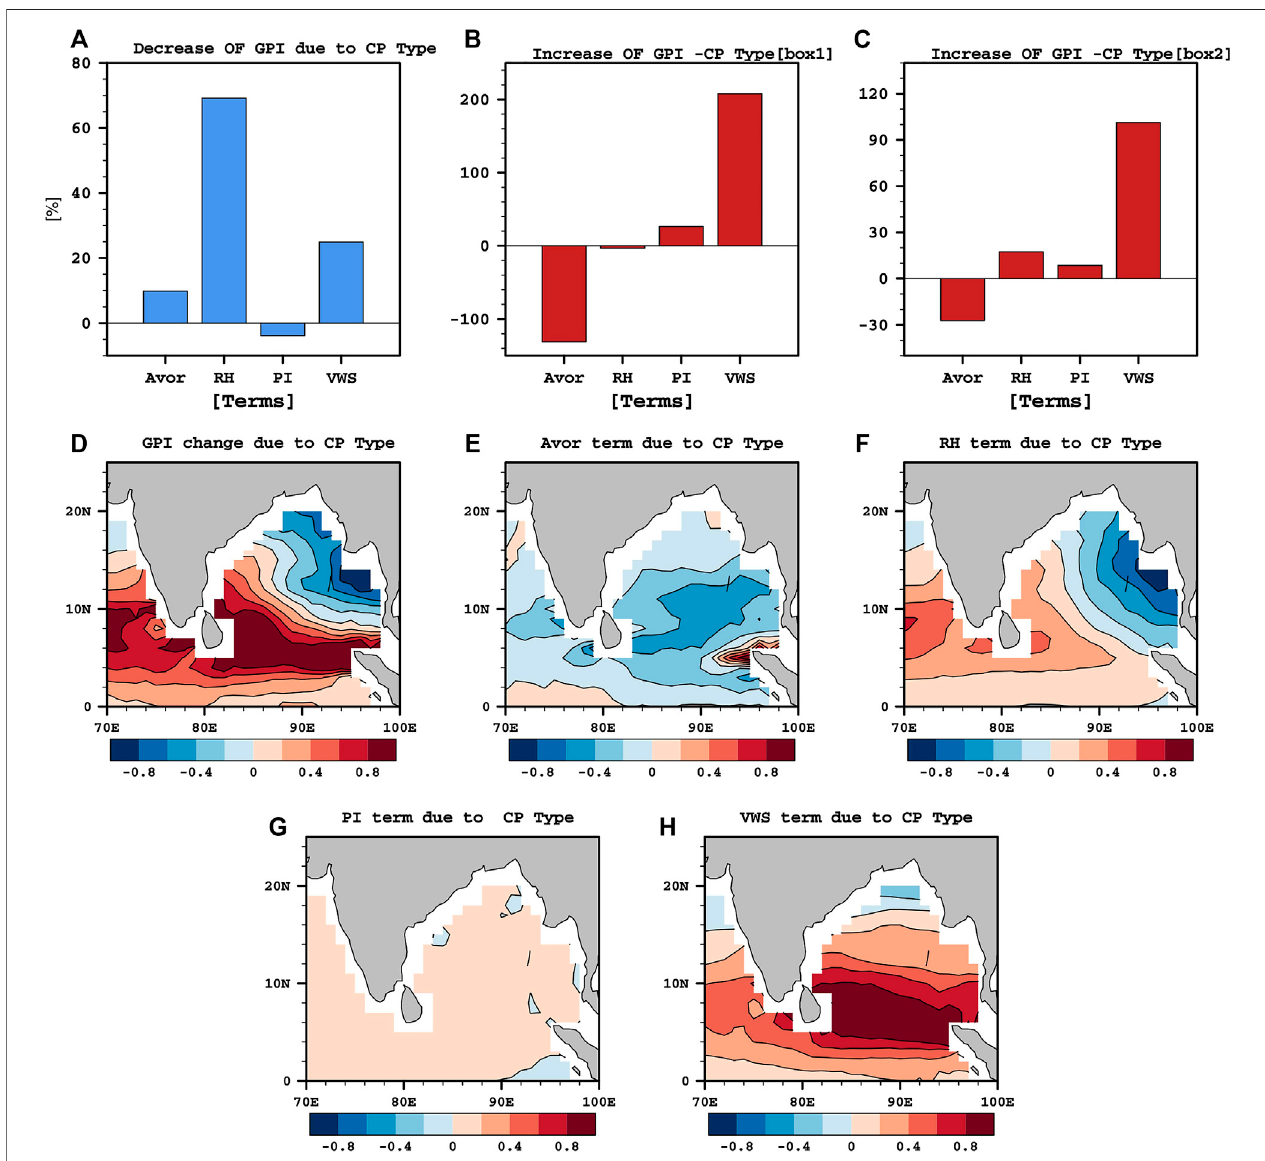
FIGURE 8 | (A) Relative contributions (percentages) of each term to the diagnosed GPI changes associated with CP El Niño during in OND over the northeastern boxedregion(17 ° – 23 ° N,87 ° – 95 ° E)and( B) inredbox1(10 ° – 16 ° N,81 ° – 90 ° E), (C) redbox2(3 ° – 8 ° N,82 ° – 96 ° E)in Panel6F . (D) DiagnosedGPIchangeintheBoBdueto CP El Niño and the spatial distribution of diagnosed four large-scale terms; (E) absolute vorticity at 850 hPa (Avor), (F) relative humidity at 700 hPa (RH), (G) potential intensity (PI) and (H) vertical wind shear (VWS).